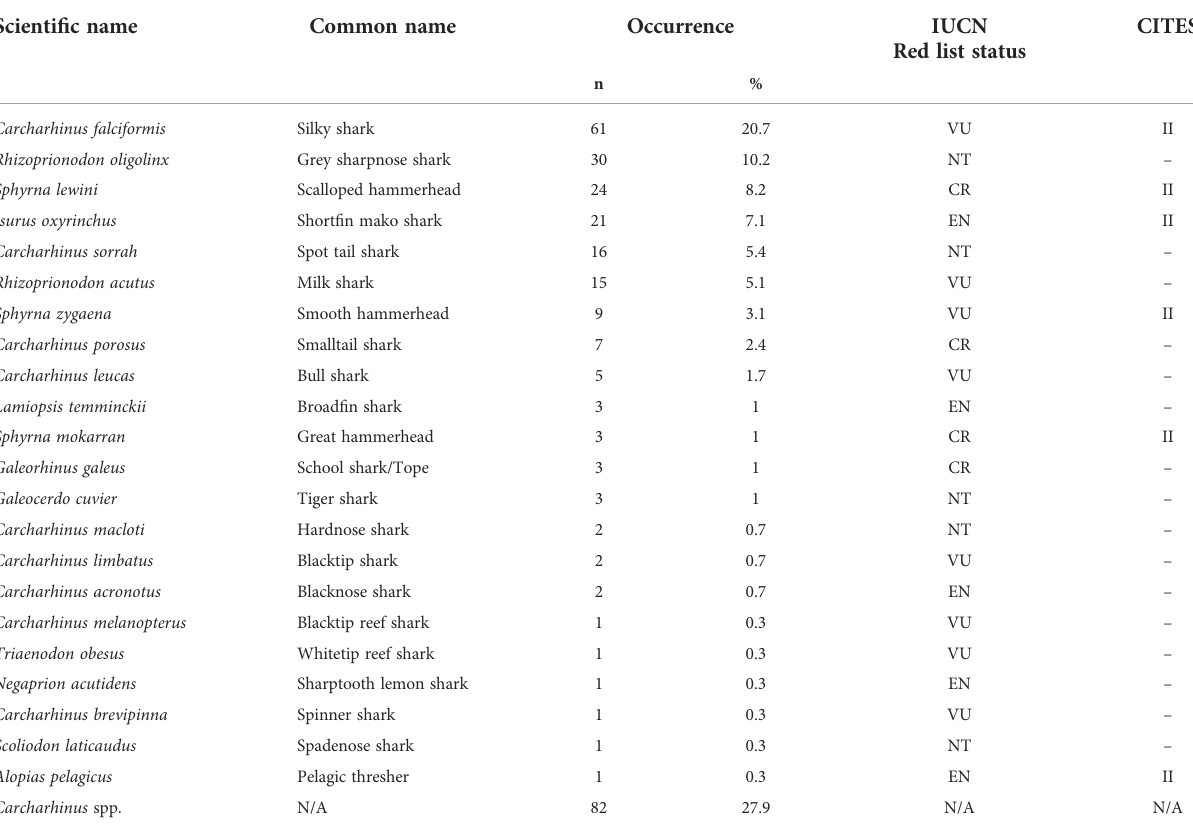
TABLE 1 Details of species identi fi cation, common names, occurrence, the IUCN Red List status (CR, critically endangered; EN, endangered; VU, vulnerable; NT, near threatened; LC, least concern), and CITES appendix